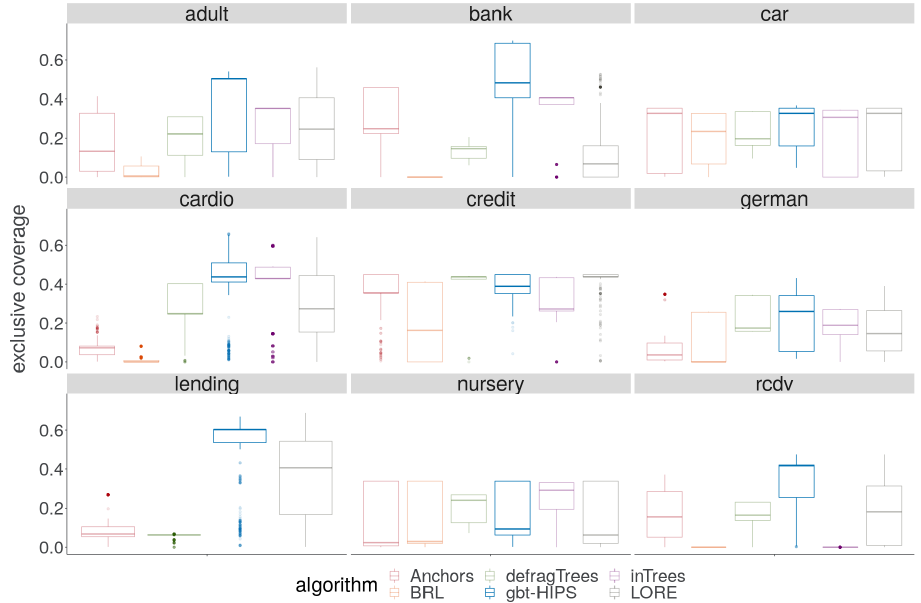
Figure 4. Distribution of exclusive coverage for stochastic GBT model